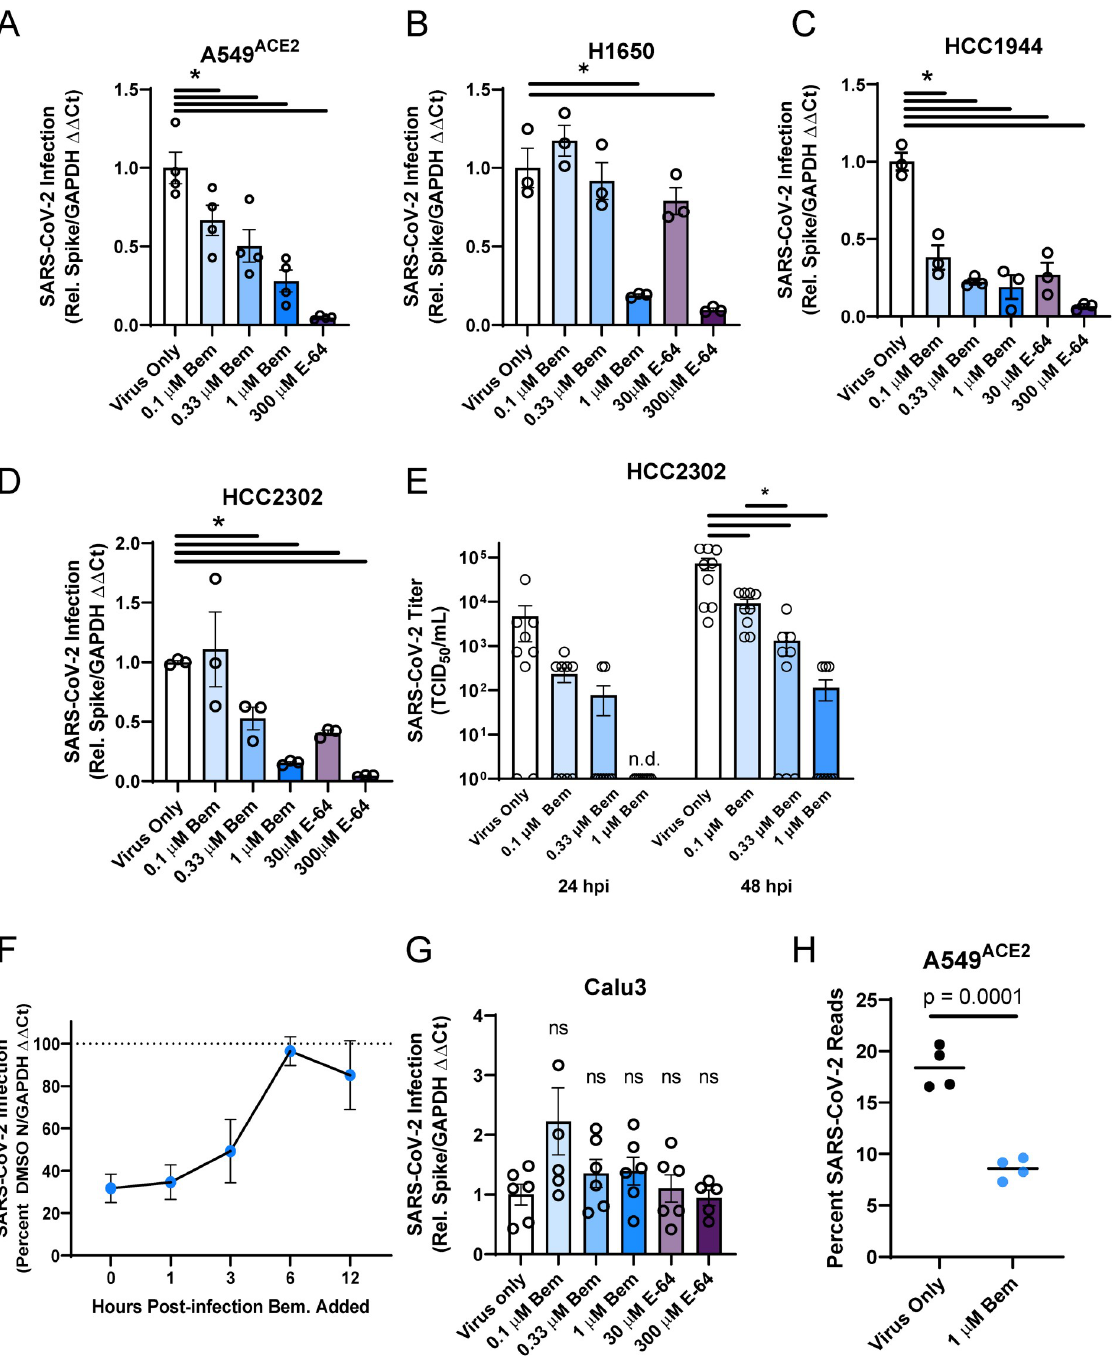
Fig 5. AXL inhibition reduces SARS-CoV-2 infection in human lung cells. A-E) SARS-CoV-2 infection (MOI = 0.5) is reduced by AXL inhibition by bemcentinib or E64 in multiple human lung cell lines, including A549 ACE2 ( A ), H1650 ( B ), HCC1944 ( C ), HCC2302 ( D ). Inhibitors were added to cells 1 h prior to infection and maintained on the cells for the entire infection. At 24 hpi, viral load was determined. E) Infectious virus produced by HCC2302 cells was inhibited by bemcentinib. HCC2302 cells were treated with bemcentinib at the indicated concentrations and infected with SARS-CoV-2 (MOI = 0.5). Input virus was removed 6 hpi and media containing the appropriate bemcentinib concentration was added. Supernatant was collected at 24 and 48 hpi and titered by TCID 50 assays on Vero E6-TMPRSS2 cells. TCID 50 /mL was calculated by the Spearmann-Karber method. F) Timing of effect bemcentinib inhibition of SARS-CoV-2 infection. In time- of-addition studies, SARS-CoV-2 (MOI = 0.01) was added to infected H1650 cells (human lung cells) to initiate the experiment and 1 μ M bemcentinib was added at the times noted. Cells were harvested at 24 hpi for viral load determinations. G) Calu-3 are insensitive to